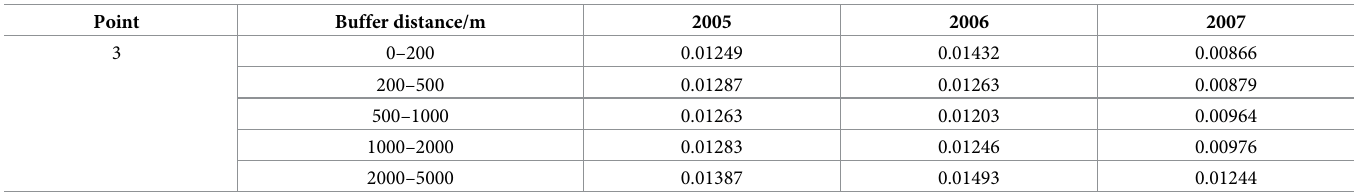
Table 5. Annual average VSWI within the radius of each interchange node before and after the construction of the Jinliwin Expressway(Show only part, S3 Table for complete table).